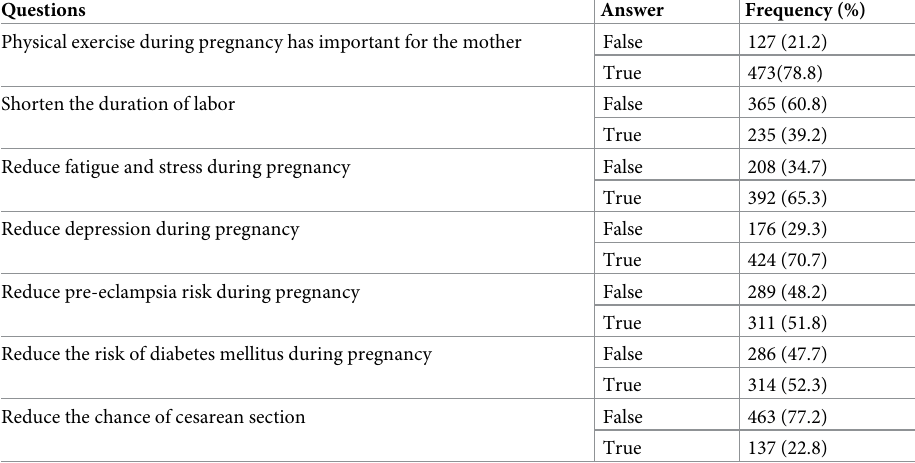
Table 5. Women’s knowledge of antenatal physical exercise benefits for the mother among pregnant women in Hawassa city, Sidama Regional State, Ethiopia, 2021.